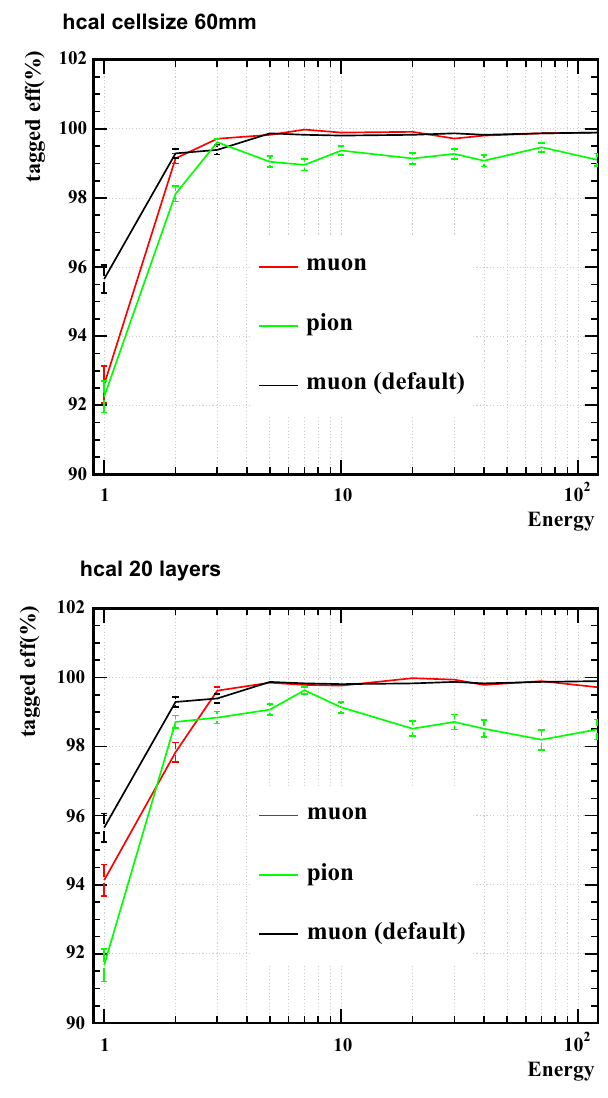
Fig. 7 The efficiency of lepton identification for two different geome- tries comparing with the default geometry effects: pion decay and π 0 generation via π -nucleon colli- sion. Meanwhile, the muons also have a small chance to be mis-identified as pions at energy smaller than 2 GeV. Figure 6 shows the significant crosstalk items ( P π a function of the particle energy in the endcap region. The green shaded band indicates the probability of pion decay before reaching the calorimeter, which is roughly compara- ble with P π μ